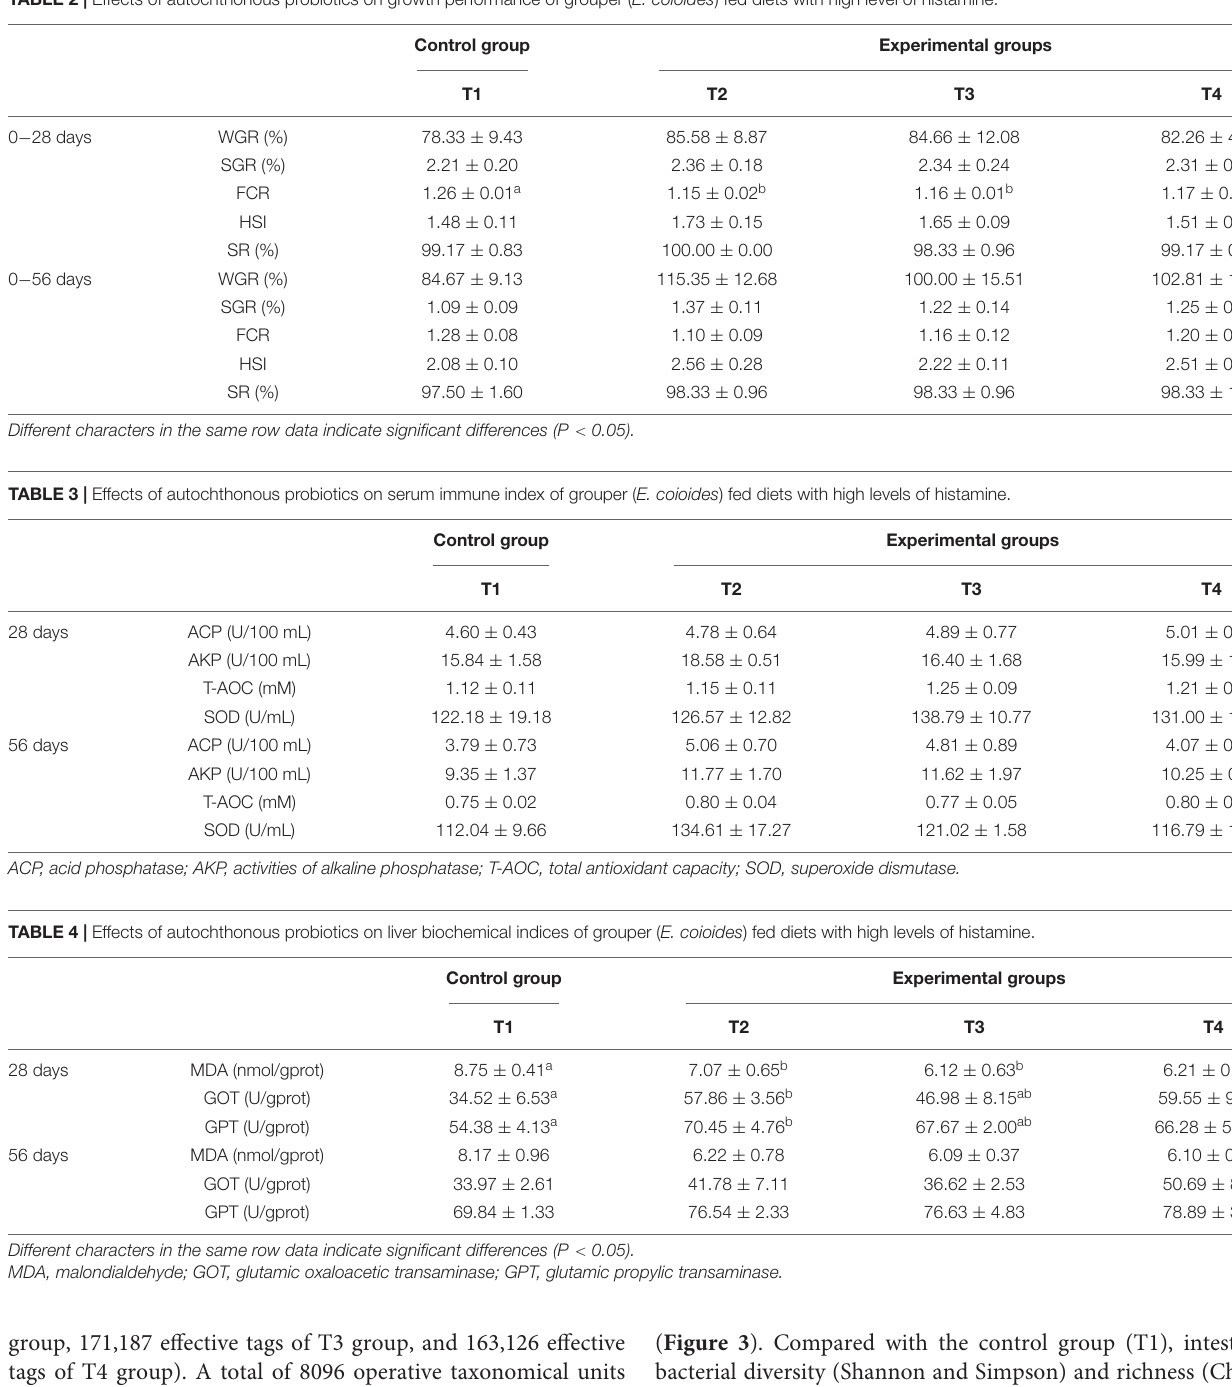
TABLE 2 | Effects of autochthonous probiotics on growth performance of grouper ( E. coioides ) fed diets with high level of histamine.